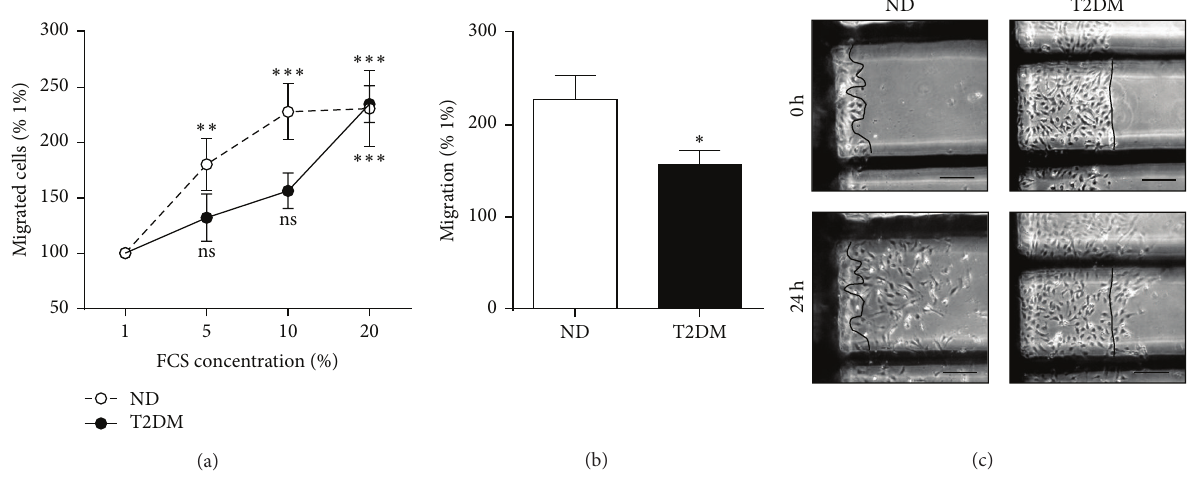
Figure 2: SV-EC migration. Confluent monolayers were quiesced and then wounded to create a cell-free area. Cells were cultured in medium containing 1–20% FCS and images taken at 0 and 24 h. The number of cells migrated past the wound edge were counted. (a) Concentration response to FCS, expressed relative to migration observed in 1% FCS ( 𝑛 = 9 , ∗∗∗ 𝑃 < 0.001 , ∗∗ 𝑃 < 0.01 , ns = not significant relative to 1% migration). (b) Summary data of migration in media containing 10% FCS ( 𝑛 = 9 , ∗ 𝑃 < 0.05 ). (c) Representative images, scale bar = 100 𝜇 m. Cells can clearly be seen migrating past the wound edge at